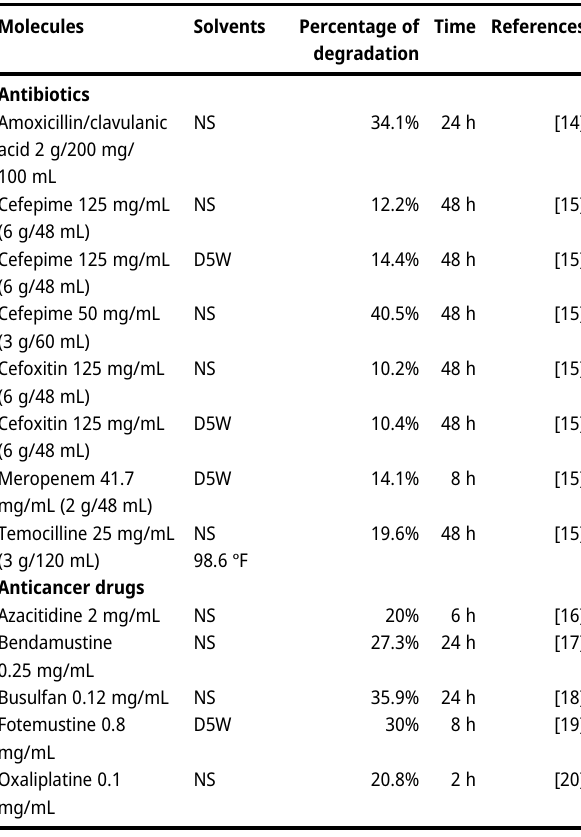
Table  : Percentage of chemical degradation of the preparation described in the literature.